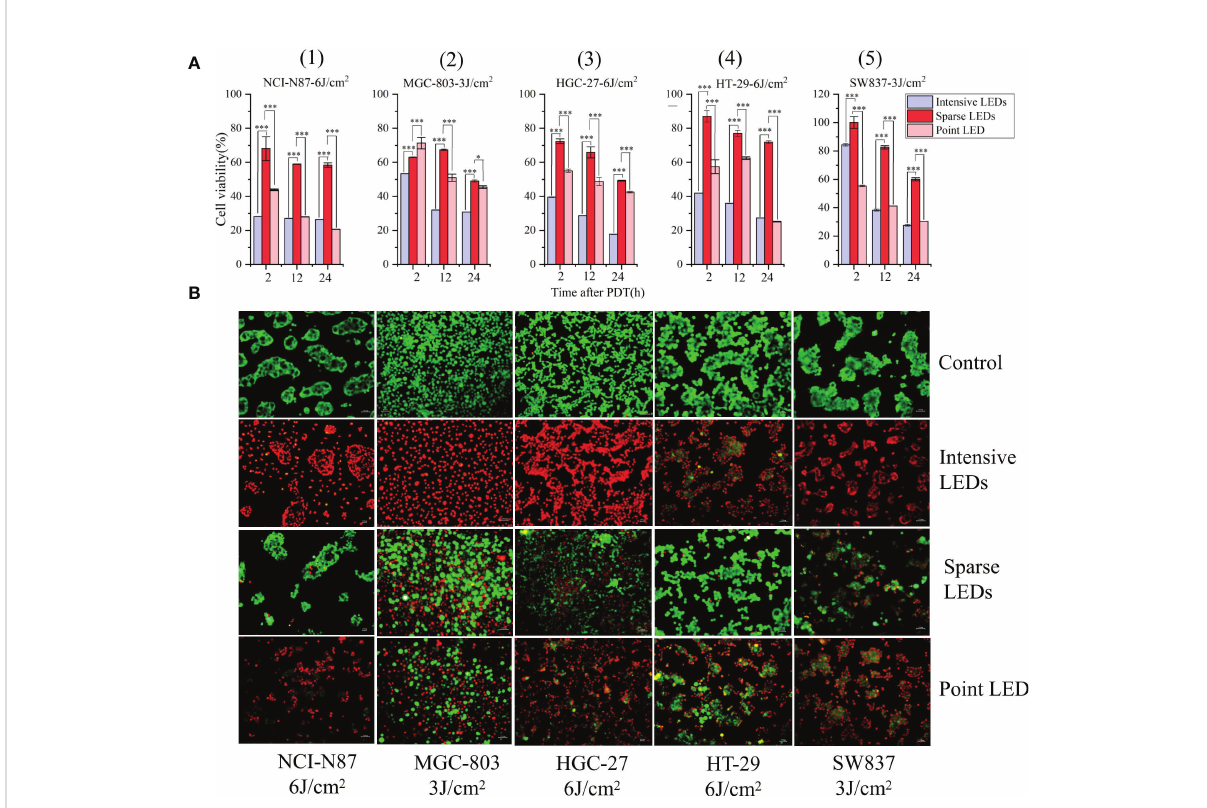
FIGURE 2 Effect of different light fi elds on the performance of PDT for GI cancer. (A) Viability of fi ve different GI cancer cells after PDT mediated by different light fi elds: (1) NCI-N87, (2) MGC-803, (3) HGC-27, (4) HT-29, and (5) SW837. (B) Differences in cell viability after irradiation with no light (control), uniform light fi eld (intensive LED array), non-uniform light fi eld (sparse LED array), and Gaussian-like light fi eld (point LED array). Cells were stained with Calcein AM/EthD-1 at 24 h post-PDT. Calcein AM (green) and EthD-1 (red) indicate living and dead cells, respectively. (*P < 0.05, and ***P < 0.001 by one-way ANOVA. Mean ± SD in bar